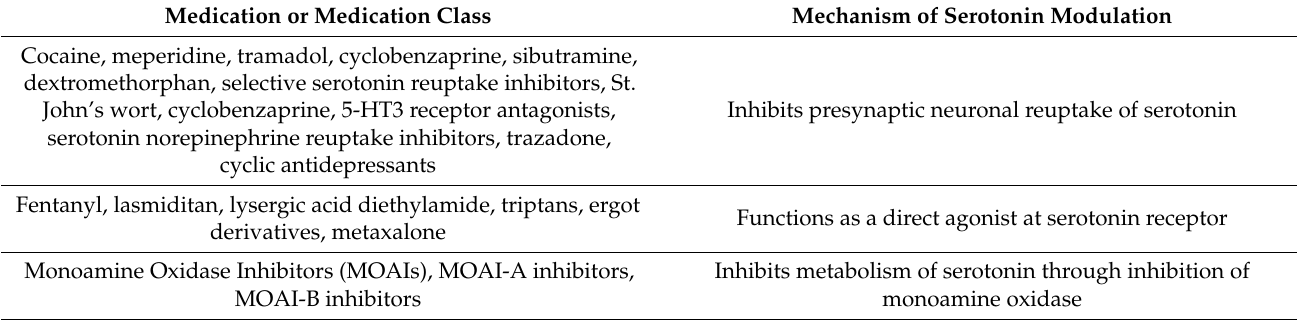
Table 2. Triggering agents of serotonin